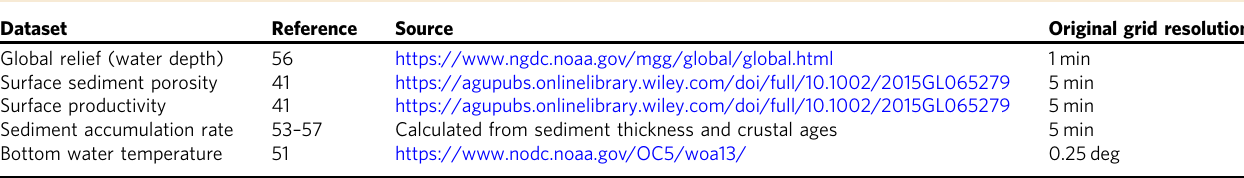
Datasets used in magnesium fl ux regression models, with online sources and spatial